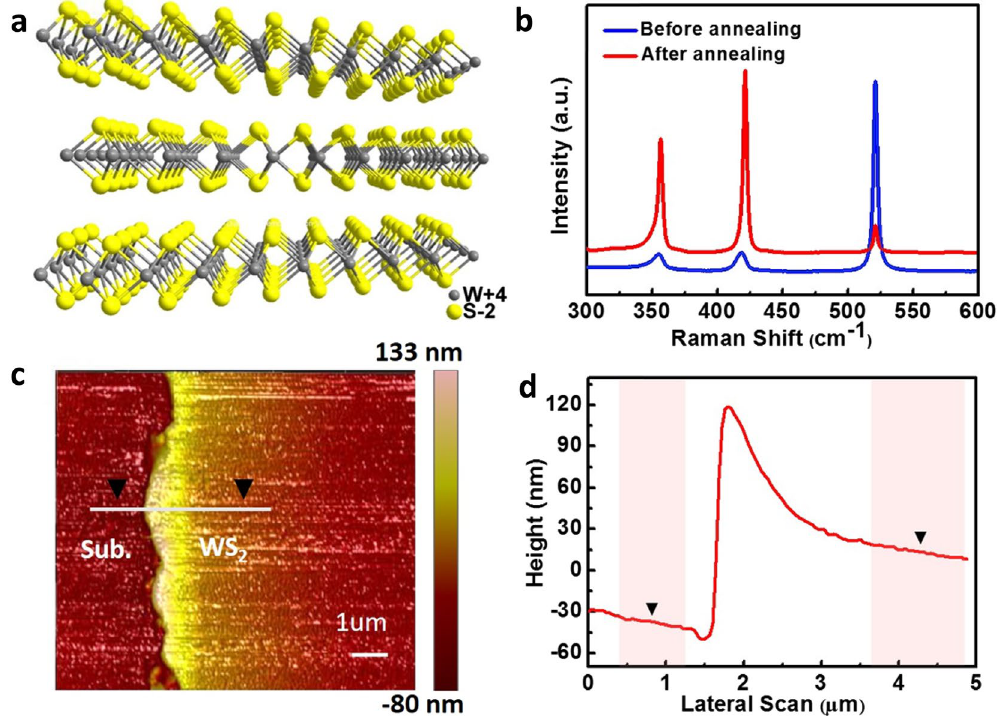
Figure 2. ( a ) Side view of the atomic structure of WS 2 layers. ( b ) Raman spectra of WS 2 films on Si substrate before and after annealing. ( c ) AFM image of annealed WS 2 film with edge area. ( d ) Height information along the white line marked in ( c